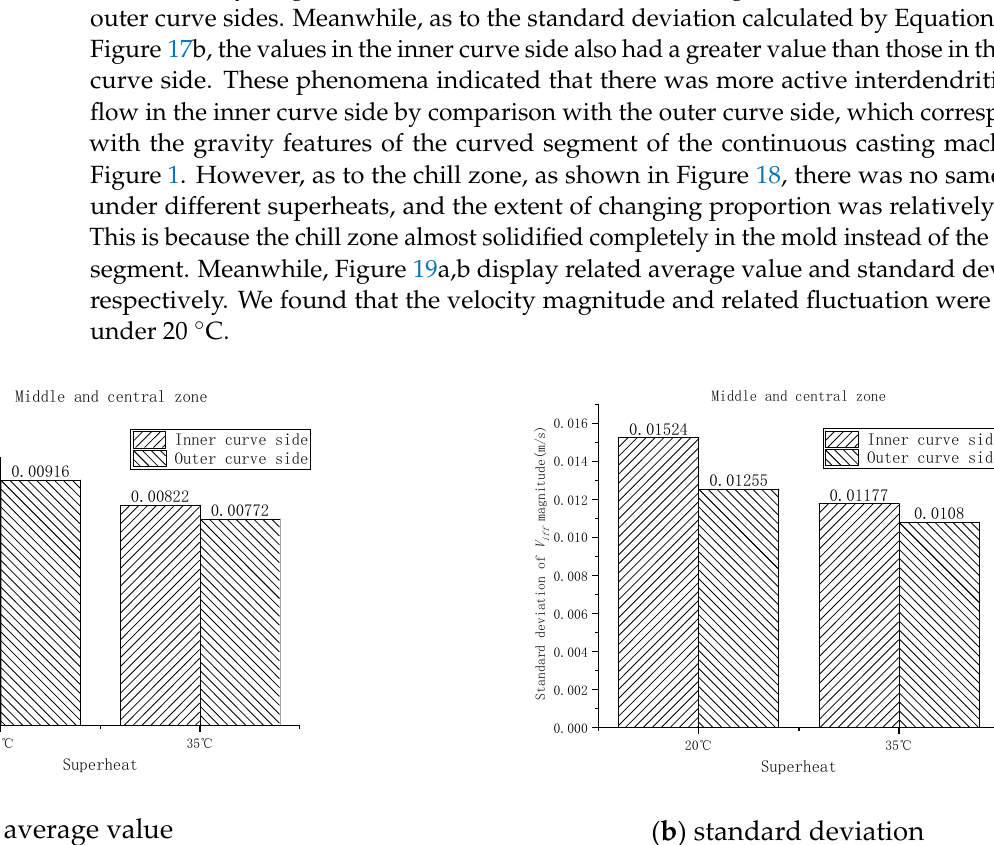
Figure 16. The magnitude of interdendritic fluid flow velocity